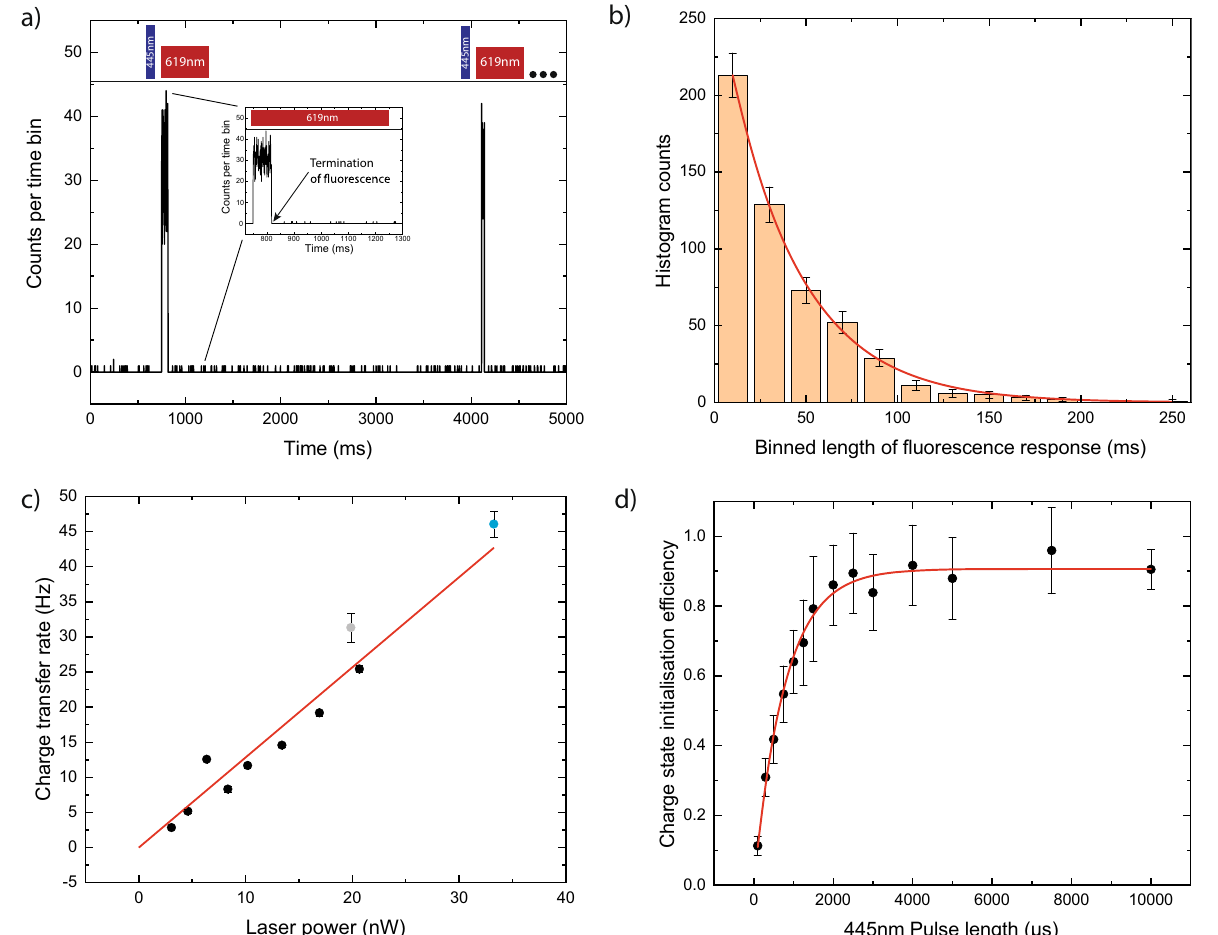
Fig. 2 Electron capture and charge initialisation of a single SnV − centre. a Exemplary part of a measurement sequence of the charge initialisation and electron capture experiments on a single SnV − centre (Emitter 1). After the 10 ms laser pulse at 445 nm initialises the charge state, a fl uorescence response by the 1 s long resonant laser pulse on the C-transition is visible. The fl uorescence response lasts until electron capture occurs. b Histogram of the lengths of the fl uorescence responses for a given resonant laser power of 20.7 nW. An exponential fi t yields the charge state lifetime until charge transfer occurs. This lifetime translates directly to a charge transfer rate for every given laser power. y-errors (s.d.): Poisson distributed count rate errors. c Charge transfer rate plotted against the resonant excitation laser power. The linear dependence of the charge capture rate on the power indicates a single photon process from the excited state, since termination of fl uorescence does not occur, if the laser is not resonant with the C-transition. The blue data point corresponds to the laser power chosen for the charge state initialisation measurement in ( d ), while the greyed out data point results from a measurement aborted earlier than the others. y-errors (s.d.): Fitting error from measurements in ( b ). d Measurement of the charge state initialisation ef fi ciency. The 445 nm laser pulse of variable pulse length is followed by a 0.5 s long resonant laser pulse with a power chosen such, that electron capture occurs with a probability close to unity for each pulse. The initialisation ef fi ciency is extracted by counting the number of fl uorescence response pulses that occur and dividing them by the total number of pulses. For increasing pulse length of the blue laser, the initialisation ef fi ciency follows an exponential law with a time constant of τ CI = 780(27) μ s and saturates at 91(1) %. y-errors (s.d.): Poisson distributed count rate